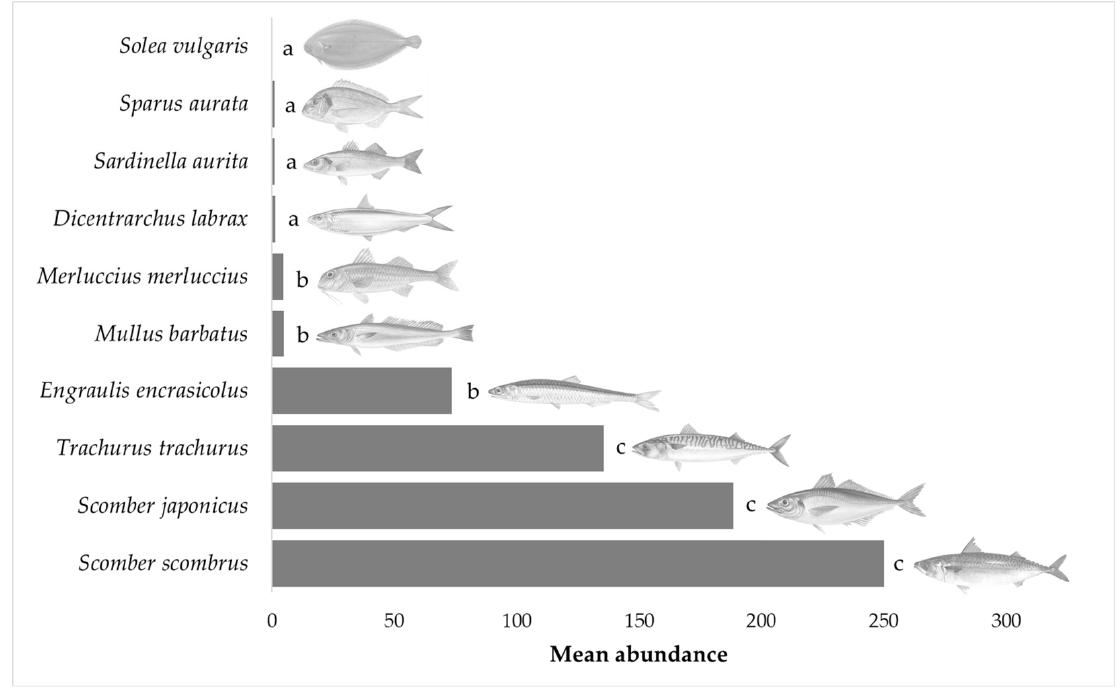
Figure 4. Mean abundance (helminths/host) of anisakid L3 type I larvae observed in the fish species. Bars sharing the same letters are not significantly different ( p < 0.05).